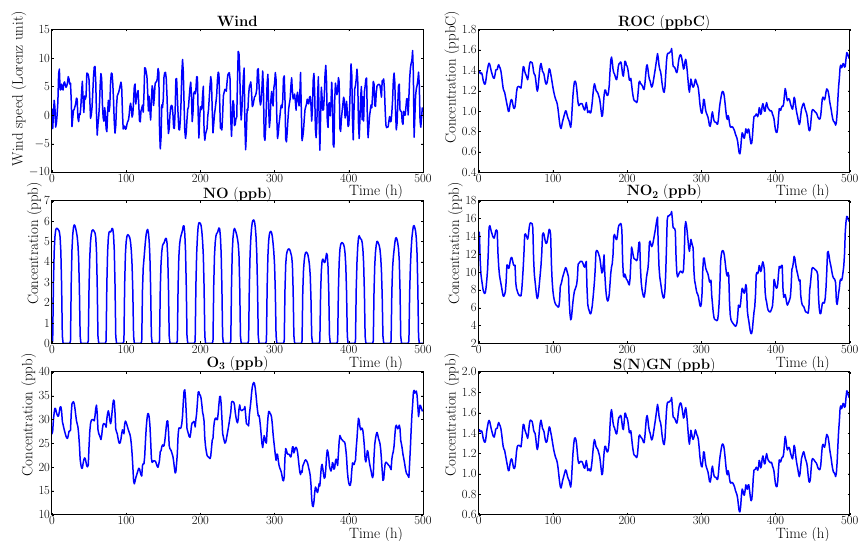
Figure 4. Time evolution of the L95-GRS variables at one grid point with a time rescaling of α = 20 applied to the L95 model. The L95 variables, flagged “Wind”, are shown with the original Lorenz unit, while the concentration unit is ppb (ppbC for